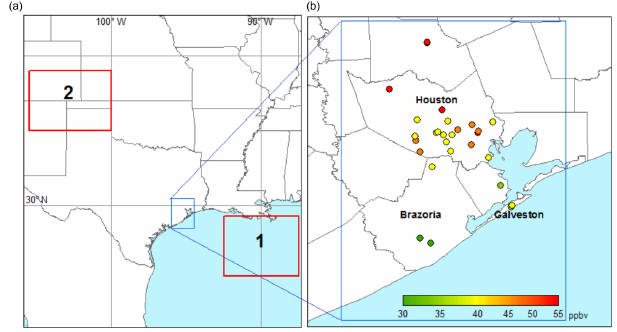
Figure 1. (a) Locations of the HGB region (blue box). The red boxes show the regions used to define the BH intensity indices BHI; (b) locations of the CAMS sites within the HGB region and the long-term (1990–2015) mean MDA8 ozone from June to